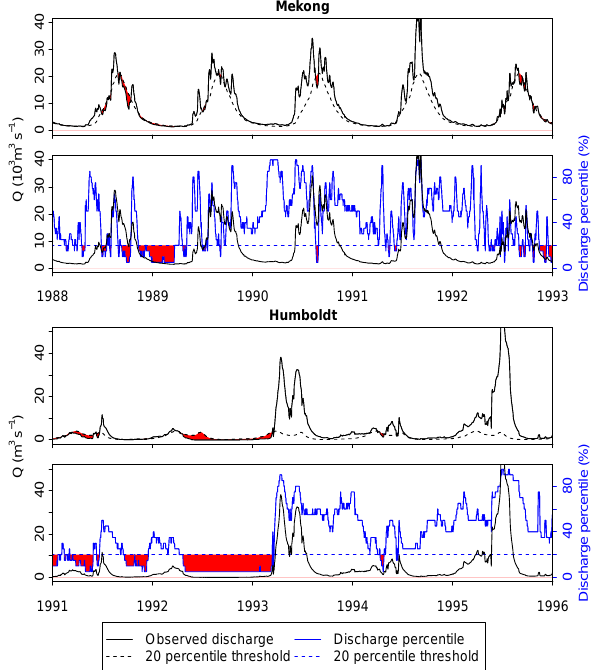
Fig. A3. Drought events (indicated in red) identified by the different methods for the Mekong and Humboldt Rivers. Upper panel: TLM for Mekong River; second panel: combined method for Mekong River; third panel: TLM for Humboldt River; fourth panel: com- bined method Humboldt River. In all panels, the observed dis- charges are given (black line) and the threshold values (here the 20th percentile, dashed lines). From the observed discharge, per- centile values for each day are calculated (blue